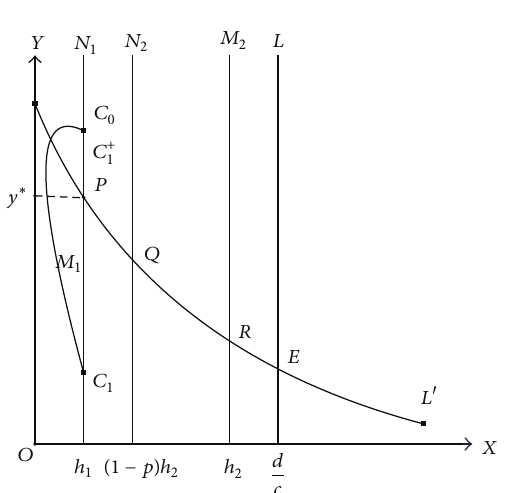
Figure 4: The orbit starting from the point 𝐶 0 above 𝑃 (Case 1 in Section 4.1.1).